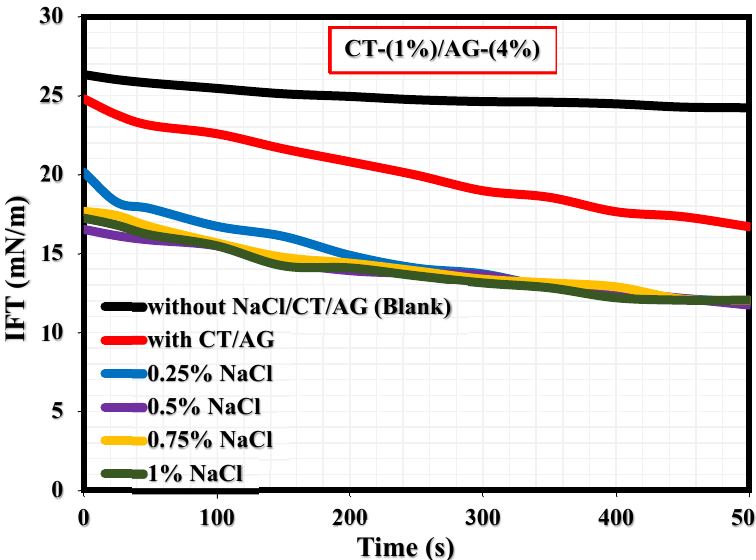
Figure 10. Effects of NaCl salt on the dynamic IFT at diesel/water interface.